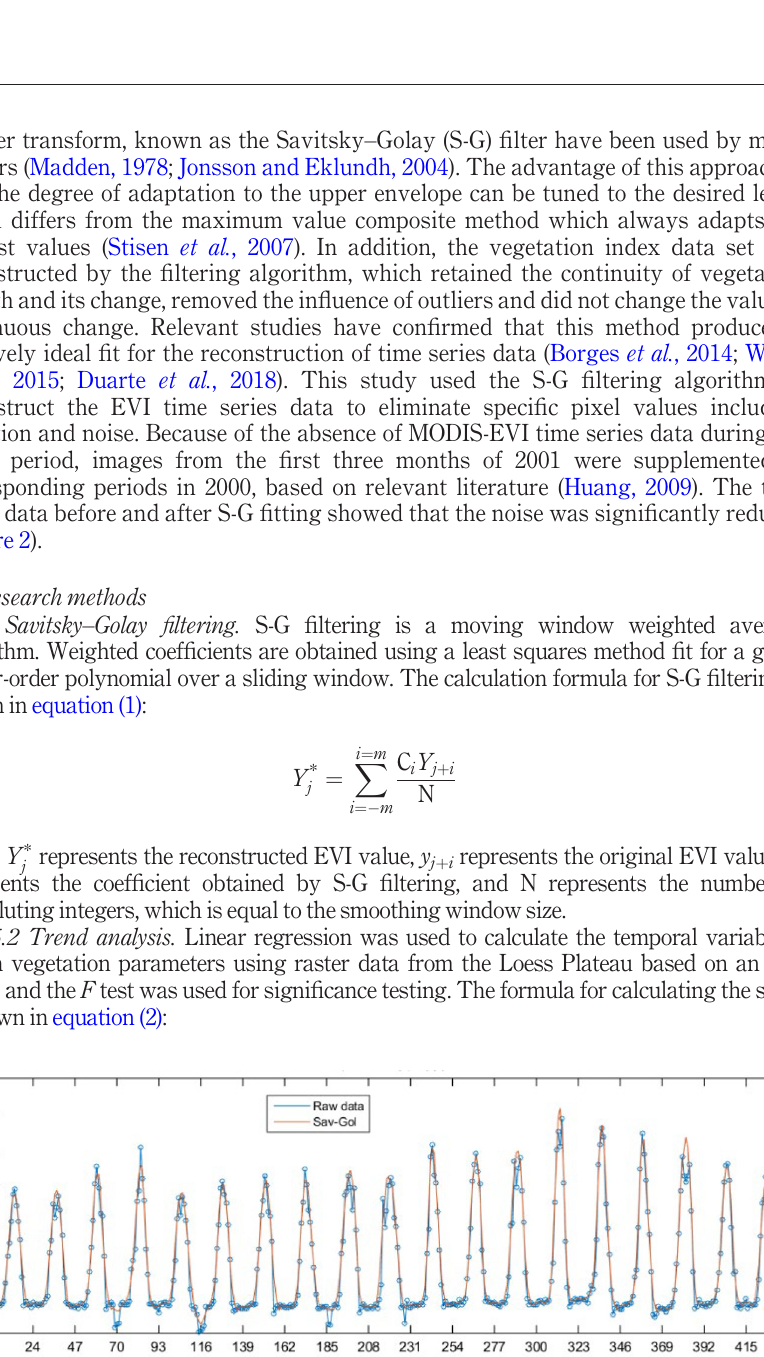
Figure 2. MOD-EVI time